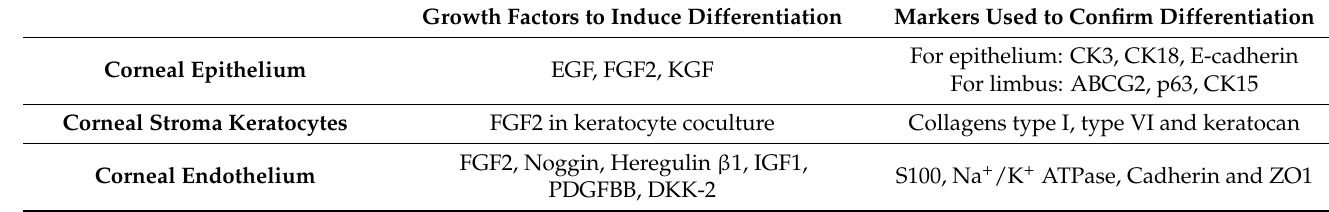
Table 1. MSC differentiation into the different corneal cell lines. Growth factors used in vitro for this purpose, and the markers commonly studied to confirm the correct differentiation into each corneal cell